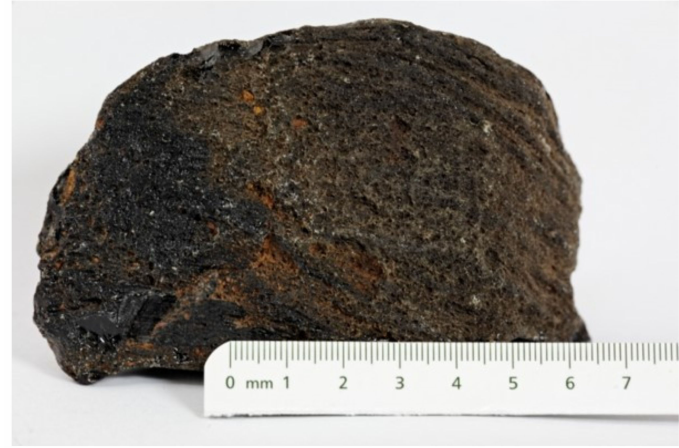
Figure 4. A Muong Nong tektite from Laos.